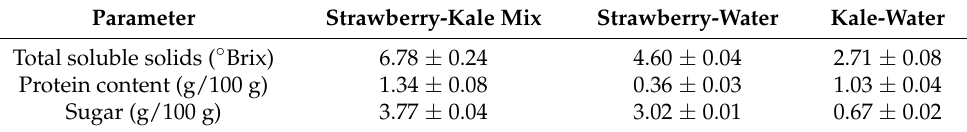
Table 1. Total soluble solids, protein contents and sugar levels of the untreated juice